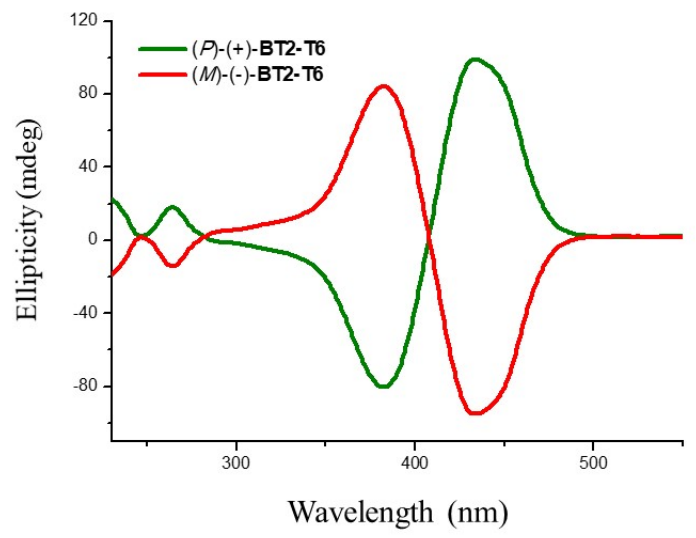
Figure 6. ECD spectra of the enantiomers of BT2 – T6